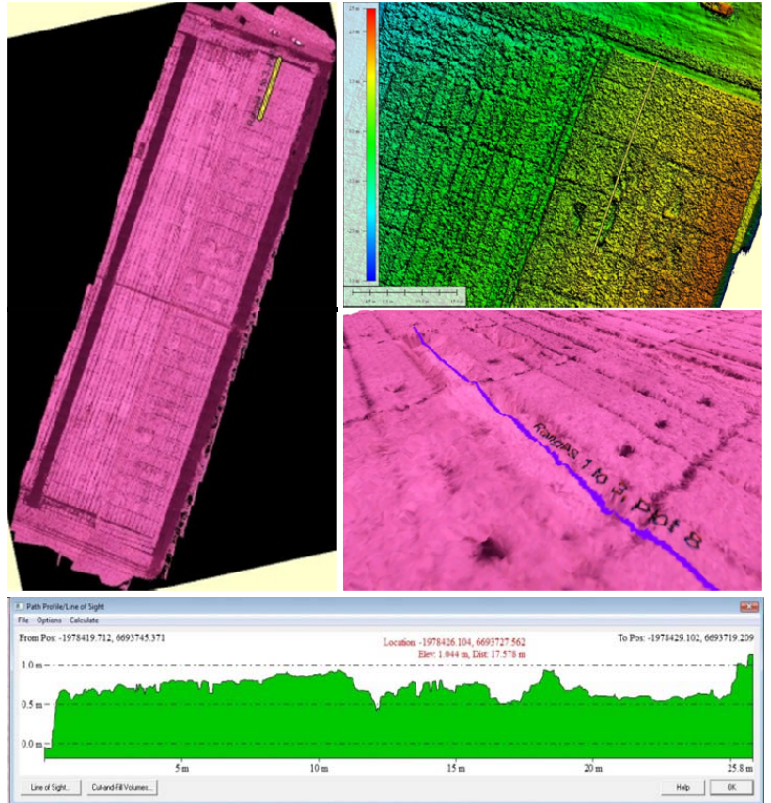
Figure 7. From an ortho-mosaic of NIR (red-edge) images ( top left ), the generated digital elevation model of wheat at about two weeks after average flowering time ( top right ) with a transect highlighted. A 3D view of the height transect through partially lodged plots is shown on a close-up of the DEM draped with the near-infrared ortho-mosaic ( middle right ), which allows the estimation of canopy height across three and a half 7-m plots ( bottom ). The dark squares in the near-infrared image are where sample quadrats were cut at